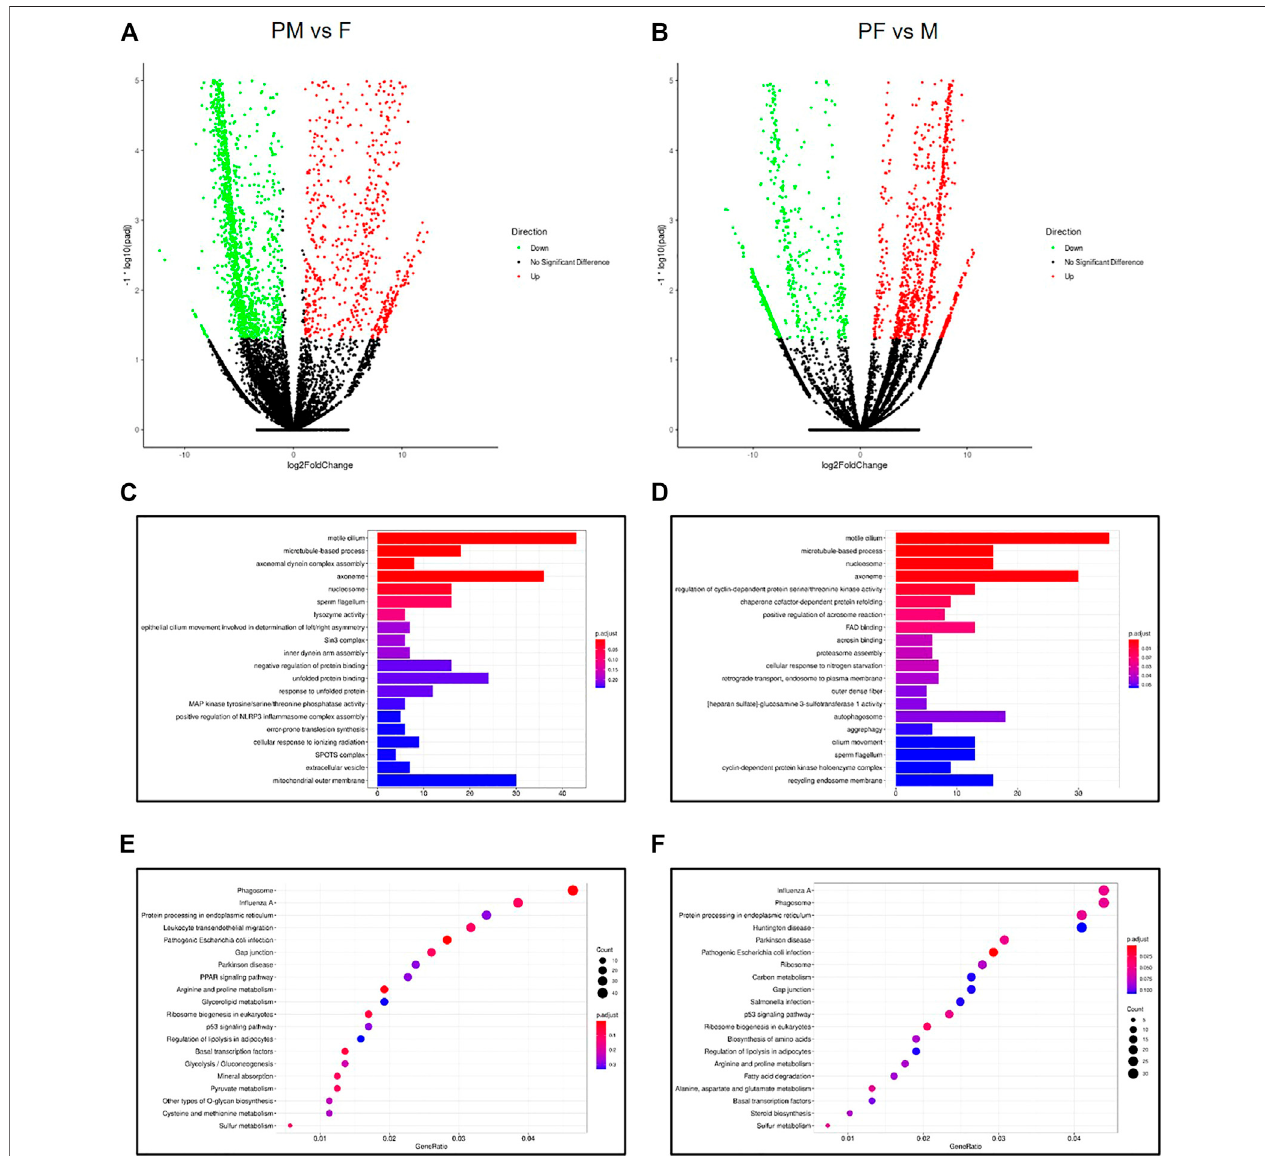
FIGURE 5 | Analysis of m6A modi fi cation genes across gender types. (A) The Volcano map of differential m6A methylation genes between PM and F. (B) The Volcanomapofdifferentialm6AmethylationgenesbetweenPFandM. (C) TheGOenrichmentanalysisofdifferentialm6AmethylationgenesbetweenPMandF. (D) The GOenrichmentanalysisofdifferential m6Amethylation genesbetween PF and M. (E) The KEGG enrichment analysisofdifferential m6Amethylationgenesbetween PM and F. (F) The KEGG enrichment analysis of differential m6A methylation genes between PF and M.